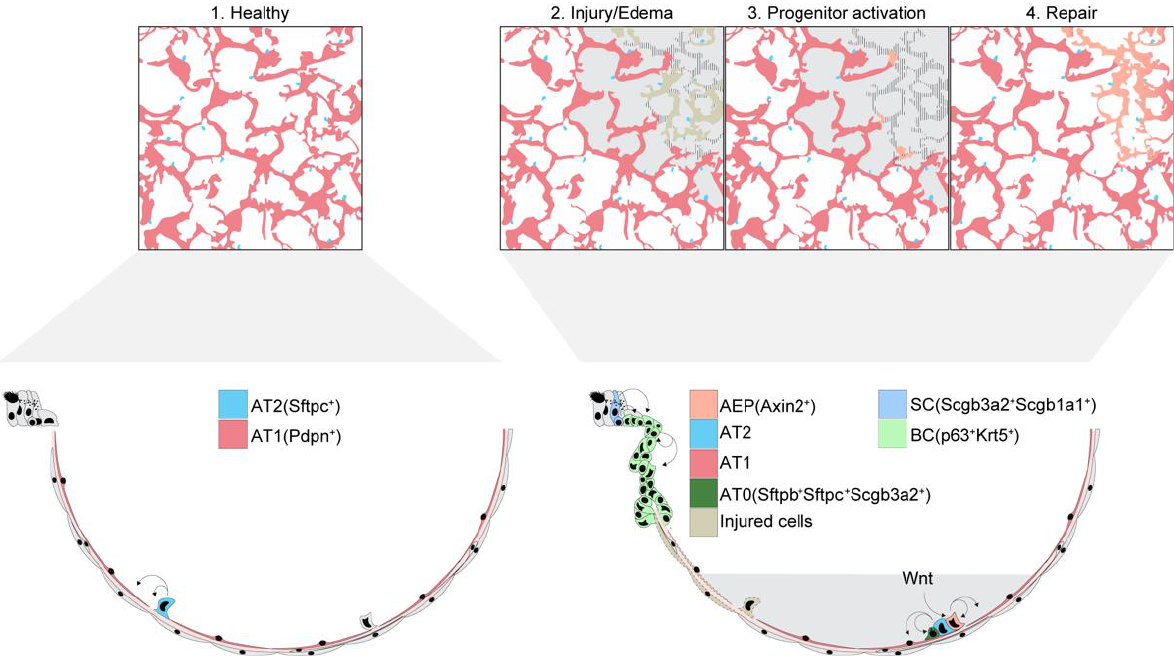
Figure 2. Alveolar epithelial responses that determine alveolar repair and regeneration . The sche- matic figures 1 – 4 show mechanisms of alveolar repair after lung injury. (1) In health, the alveolar epithelium is a continuous monolayer of squamous alveolar type 1 cells (AT1) and cuboidal alveolar type 2 (AT2) cells. (2) After severe lung injury, recovery of gas exchange function requires the re- placement of damaged alveolar epithelial cells and the restoration of alveolar architecture. (3) Alve- olar epithelial progenitors (AEPs) respond robustly to local production of Wnts to (4) rapidly ex- pand and replenish AT2 cells. In turn, AT2 cells transition through the AT0 cell state to differentiate